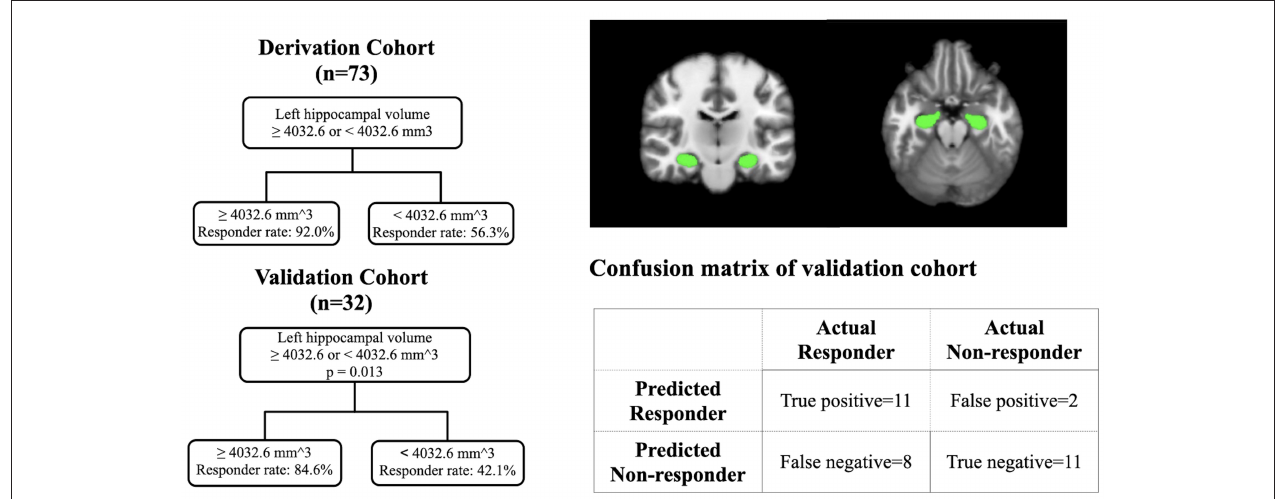
FIGURE 2 | The prediction model in the derivation cohort and validation cohort with the visualization of